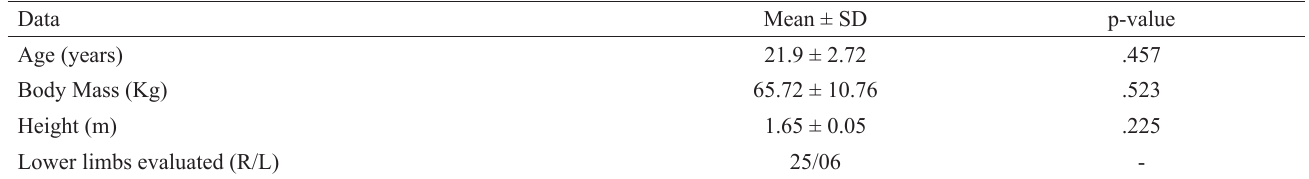
1. Summary of subject